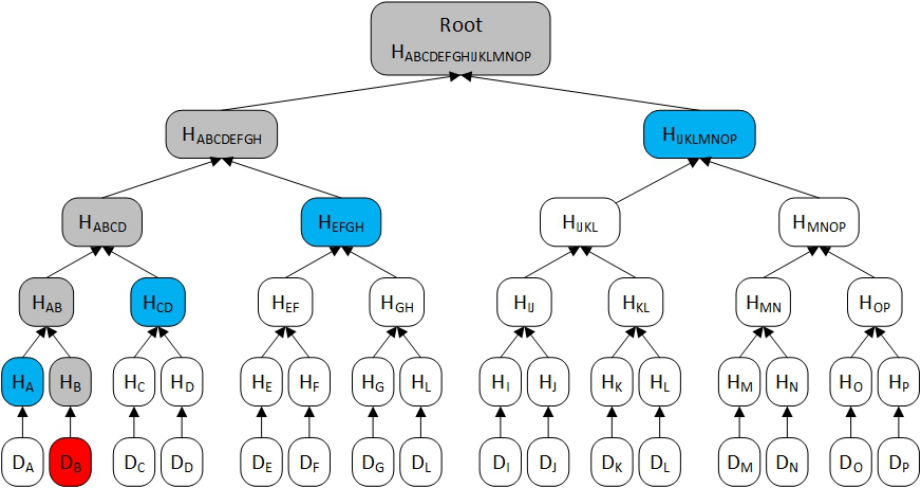
Figure 1. Merkle